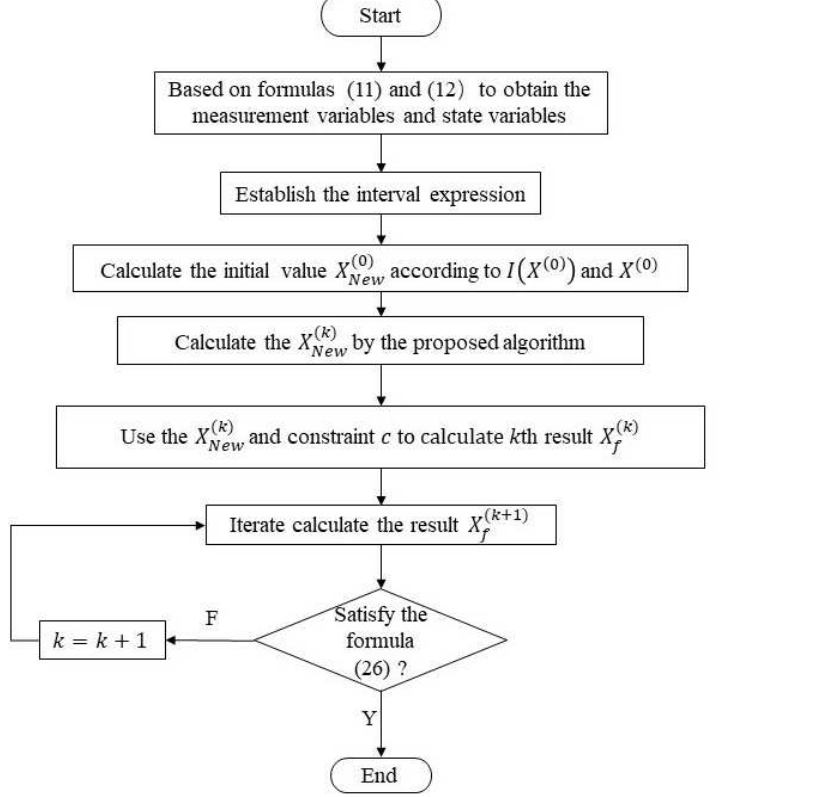
Figure 1. Flow chart of the proposed interval state estimation